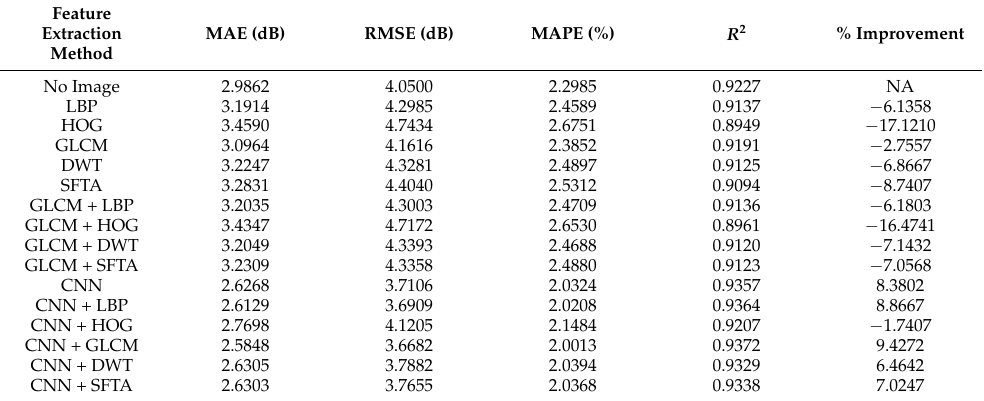
Table 3. XGBoost performance on combinations of numeric features and features from one or two feature extraction